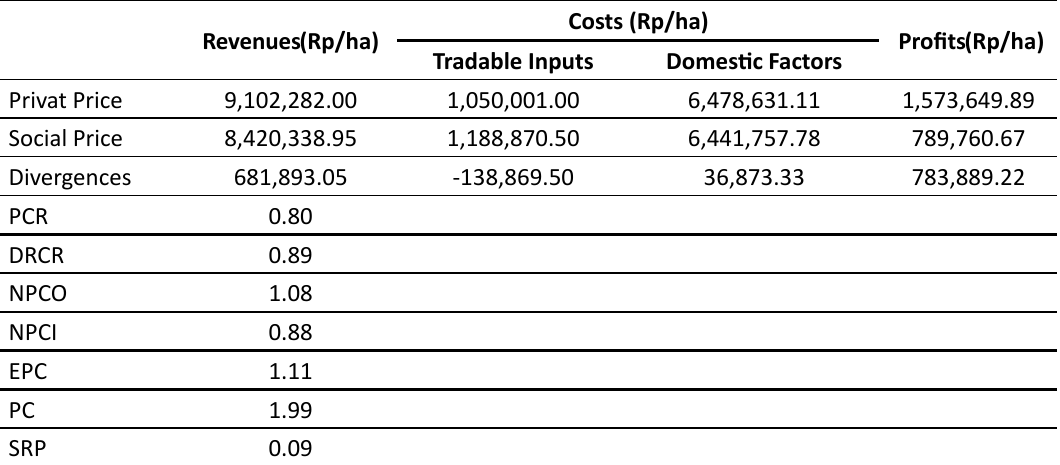
Table 2: Results of Policy Analysis Matrix (PAM) for Soybean Farming, 2016 Costs (Rp/ha) Revenues (Rp/ha) Profits (Rp/ha) Tradable Inputs Domestic Factors Privat Price 9,102,282.00 1,050,001.00 6,478,631.11 1,573,649.89 Social Price 8,420,338.95 1,188,870.50 6,441,757.78 789,760.67 681,893.05